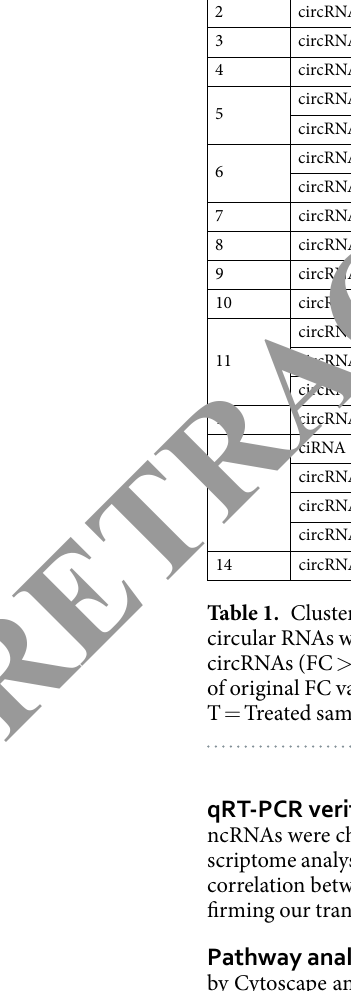
firming our transcriptomic data validity.